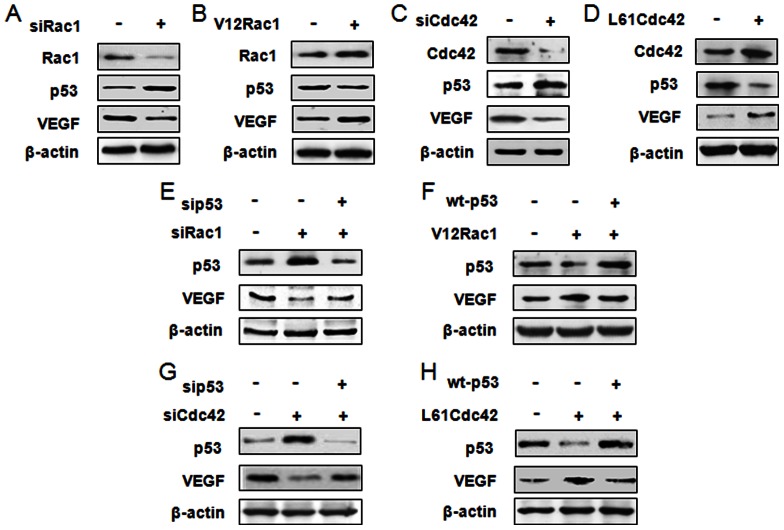
Rac1/Cdc42 regulates p53 expression to affect VEGF expression in MCF-7 cells.(A–D) MCF-7 cells were transfected with Rac1/Cdc42 small-interfering RNA (siRac1/Cdc42) or with negative control siRNA and with the plasmid pCEFL-GST-V12Rac1 (V12Rac1), pCEFL-GST-L61Cdc42 (L61Cdc42) or pCEFL-GST-neo using lipofectamine 2000 for 48 h. Protein and RNA were then extracted and subjected to western blot analyses. Total protein was subjected to 15% SDS-PAGE; membranes were incubated with anti-Rac1, anti-Cdc42, anti-p53, anti-VEGF, or anti-β-actin antibody. (E–H) MCF-7 cells were transfected with siRac1/Cdc42 or with p53 siRNA (sip53) and either activated Rac1/Cdc42 plasmid (V12Rac1/L61Cdc42) or wild-type p53 expression plasmid (wt-p53) with lipofectamine 2000 for 48 h. Protein was then extracted and subjected to 15% SDS-PAGE; membranes were incubated with anti-p53, anti-VEGF, or anti-β-actin antibody. The data represent three independent experiments.